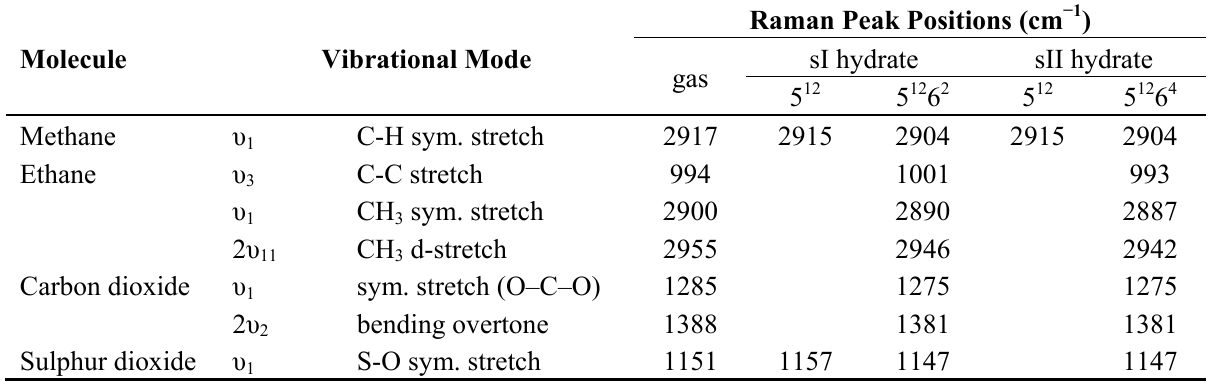
Table 1. Summary of Raman shifts for molecules measured in this